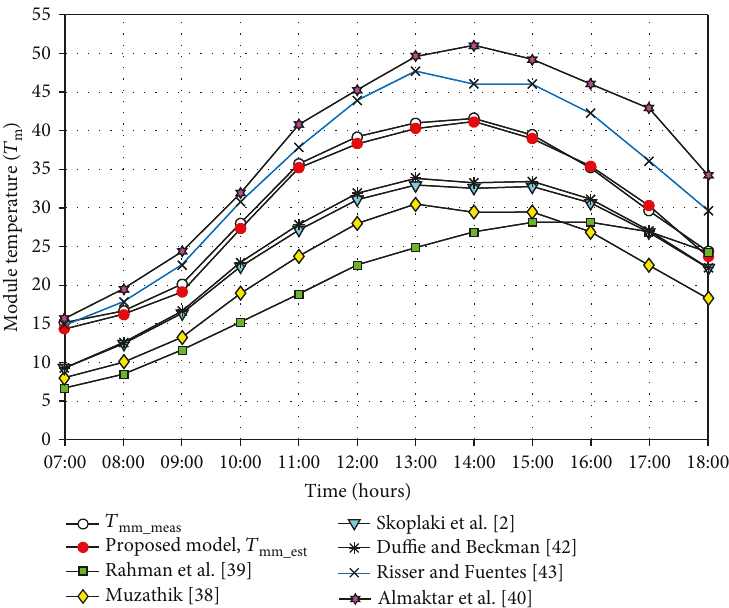
Figure 9: Proposed model estimation versus measured data and other existing model module temperature values of monocrystalline module during